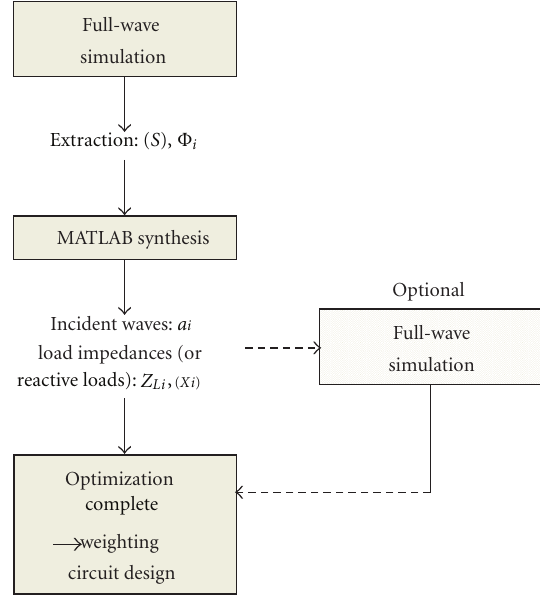
Figure 4: Synthesis approach